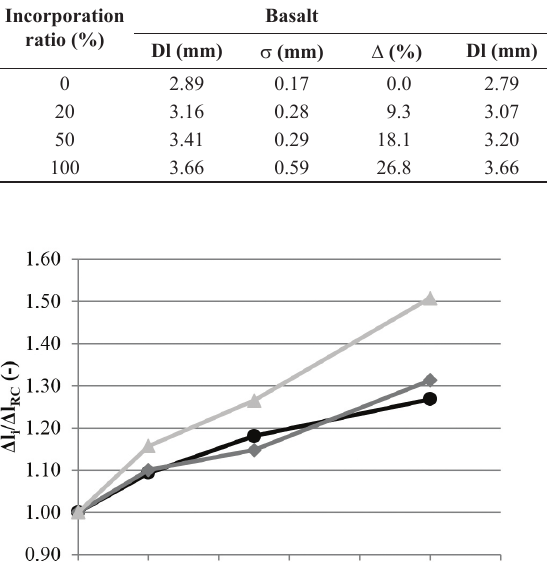
Table 7. Abrasion wear loss.